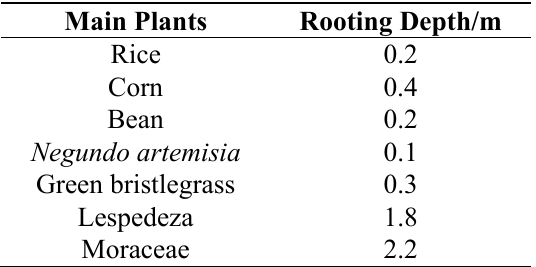
Table 1. Average rooting depths of major vegetation types on the Sanjiang Plain, Northeast China. The rooting depths were used to define their EISGD